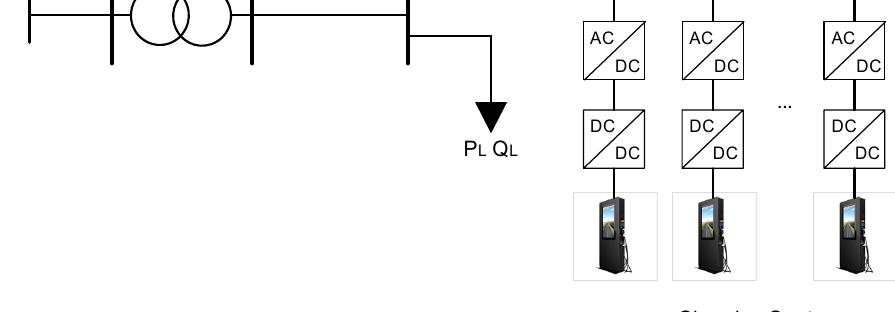
Figure 8. 10.6/0.4 kV distribution microgrid.